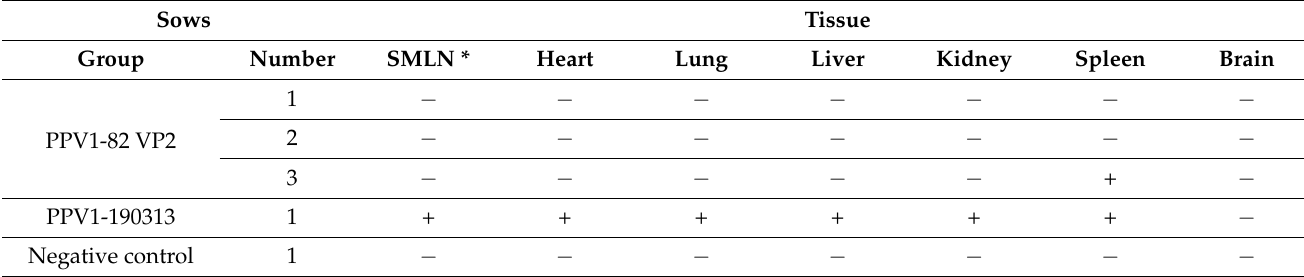
Table 4. Detection of PPV1 in tissues from pregnant sows. Pregnant sows were euthanized at 53 days postchallenge (DPC), and their tissues were collected for conventional PCR analysis; +, PPV1 -positive; − , PPV1